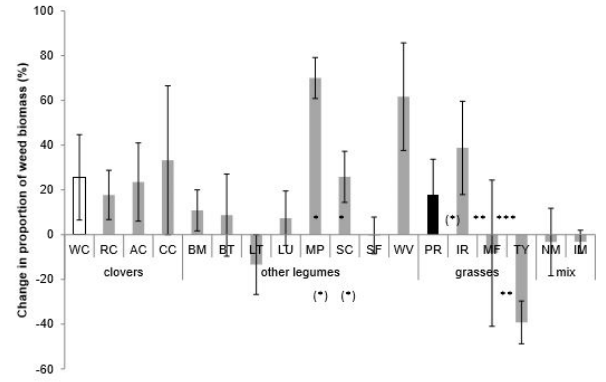
Figure 3. Proportion (in %) of weed biomass in total biomass (above ground): Absolute change from autumn 2009 to spring 2011; means and standard errors across 4 sites. Pos- itive values mean an increase in the proportion of weed biomass in the total above ground biomass over time. Signif- icance stars below the zero-line indicate whether this tempo- ral change was significantly different from zero (t-test); stars above the zero-line refer to the difference between white clover (white bar) and the other legume species and or the difference between perennial ryegrass (black bar) and the other grass species (Dunnett-test). (*): P < 0.1; *: P < 0.05; **: P < 0.01; ***: P < 0.001. For abbreviations see Table